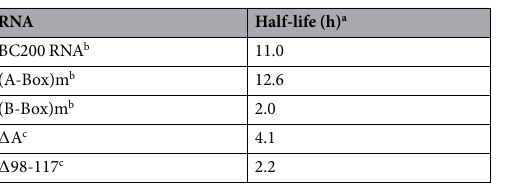
Table 2. Half-lives of exogenically or ectopically expressed BC200 RNA and its deletion or mutant derivatives. a Half-lives were determined by linear regression analysis from the data of Fig. 7. b Ectopically expressed from the H1 RNA promoter. c Exogenically expressed from the BC200 RNA